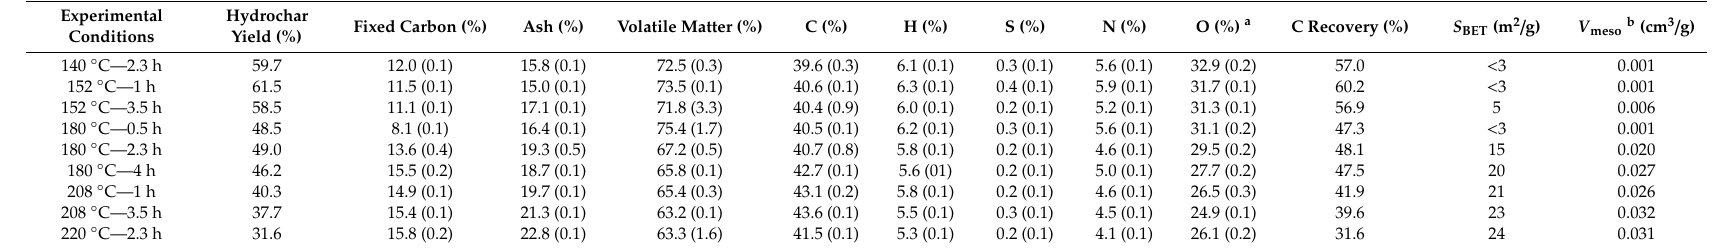
Table 2. Composition on a dry basis of the